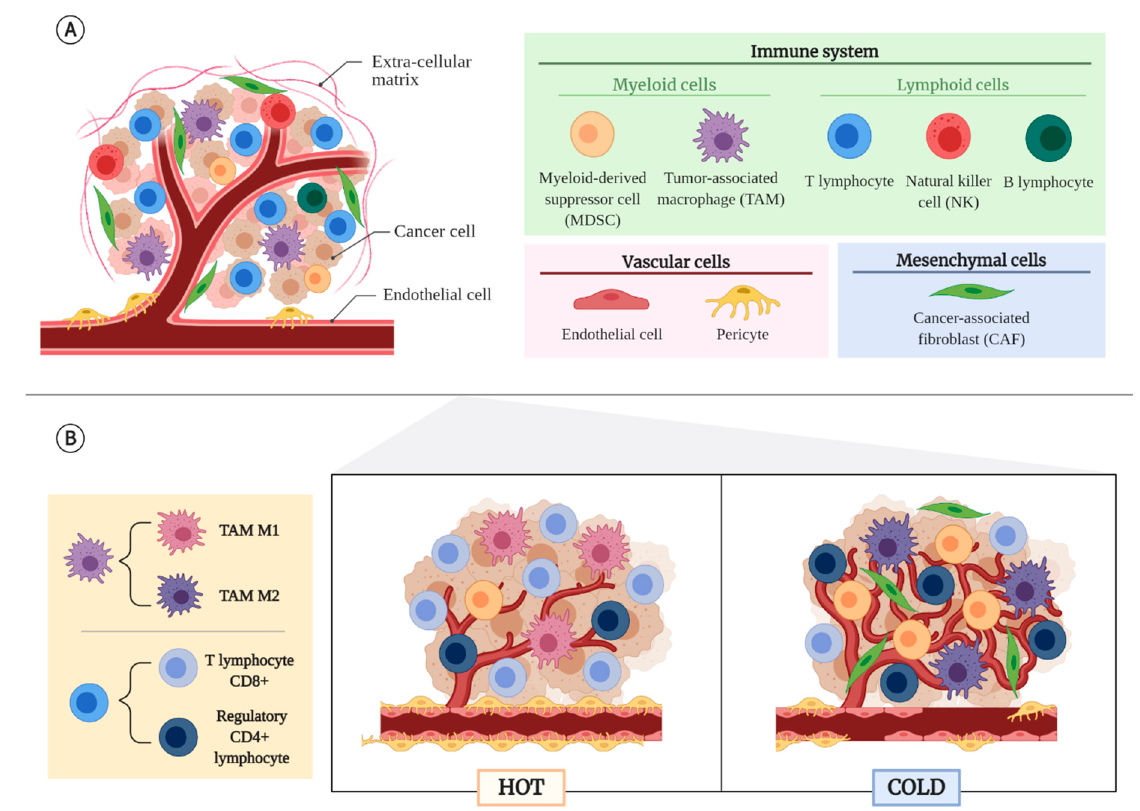
Figure 1. Tumor microenvironment (TME) . ( A ) Origins of non-cancerous cells of the TME. Non-malignant cells that form TME can be classified according to their origin as immune cells, mesenchymal cells, and vascular cells. Immune cells can also be divided in lymphoid, including T and B lymphocytes or natural killers (NKs), or myeloid cells, including tumor-associated macrophages (TAMs) or myeloid-derived suppressor cells (MDSCs). Cancer-associated fibroblasts (CAFs) are the main cell of mesenchymal origin in tumors. Endothelial cells (ECs) and pericytes form blood vessels of the tumor. ( B ) Tumor types according to their TME . Hot tumors are enriched in CD8 + lymphocytes and M1 TAMs and present low infiltration of MDSCs or CAFs resulting in a better response to immunotherapy. On the other hand, cold tumor TME are characterized by the presence of more Treg than CD8 + lymphocytes and high infiltration of M2 TAMs, MDSCs, and CAFs. Moreover, cold tumors present worst vasculature than hot tumors and they generally respond very poorly to immunotherapy. Created with BioRender.com.